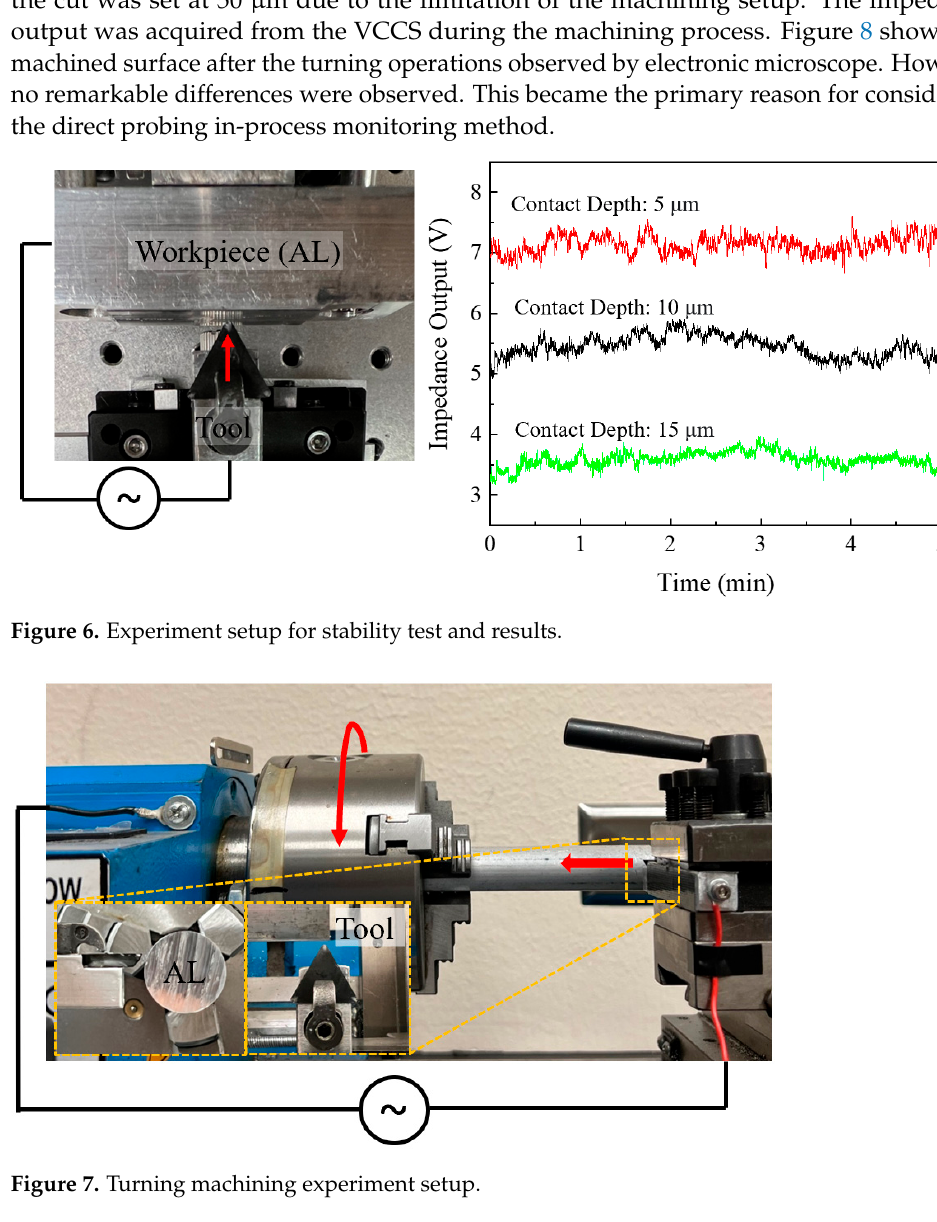
Figure 6. Experiment setup for stability test and results.